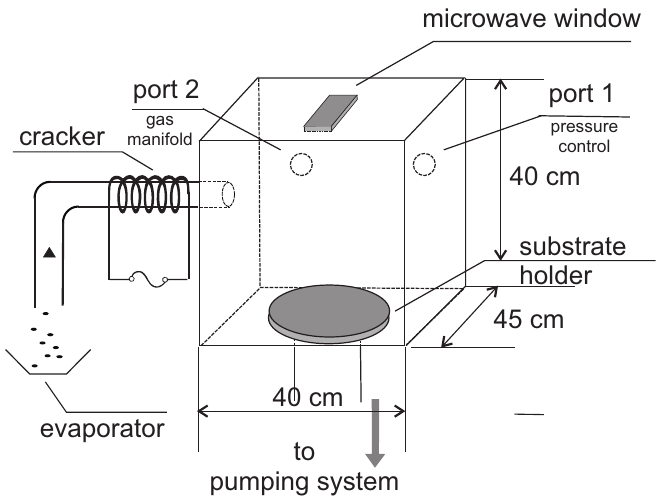
Figure 3. Sketch of the CVD reactor with microwave window and facilities for gas doping and pres- sure control. Its configuration is asymmetric with respect to gain and loss of the layer-forming vapor. The reactor was evacuated with a rotary vane pump (Leybold 65 BCS, Cologne, Germany) through a baffle, which was maintained at − 90 ◦ C to avoid contamination of unreacted monomers. Following Gorham, a precursor was evaporated between 105 and 130 ◦ C and thermally cracked in a cracking unit at temperatures driven at 700 ◦ C [14]. For medical purposes, we used the solid precursor diparylene N (Plasma Parylene Systems, Rosenheim, Germany). The pressure was controlled with a heated pressure transducer (MKS Baratron 631C-01-TBFH), which ensures long-term stability. This was confirmed with our “gauge” pressure transducer B270 from MKS, which was calibrated by MKS (MKS Germany, Munich, Germany). Because of the large thermal inertia of the evaporator and the cracker, the time lag before these temperatures were reached was approximately 45 min. was admitted at moderate flows (80 sccm) and then suddenly cut off (drop to 2.5 sccm during the coating process), which caused a steep increase within seconds and stable evaporation